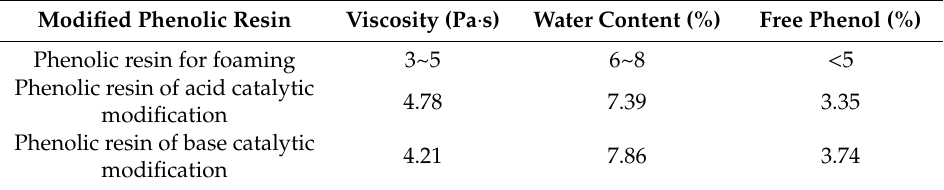
Table 2. Basic properties of resin.